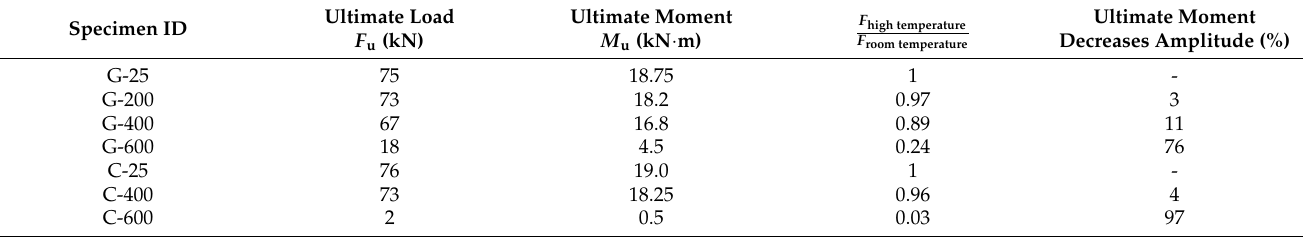
Table 4. Bending capacity of FRP-reinforced concrete